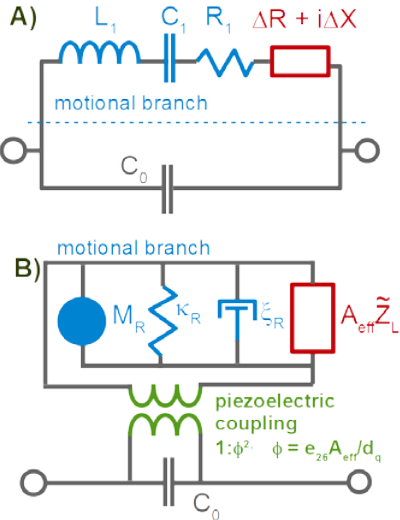
Figure 42. ( A ) The Butterworth-van-Dyke equivalent circuit (also: “4-element circuit”). This ver- sion of the 4-element circuit actually contains 5 elements because the load ( Δ R + i Δ X ) was in- of the 4-element circuit actually contains 5 elements because the load ( ∆ R + i ∆ X ) was included. ( B ) A cluded. ( B ) A version of the circuit, where the motional branch is drawn with mechanical ele- version of the circuit, where the motional branch is drawn with mechanical ments.